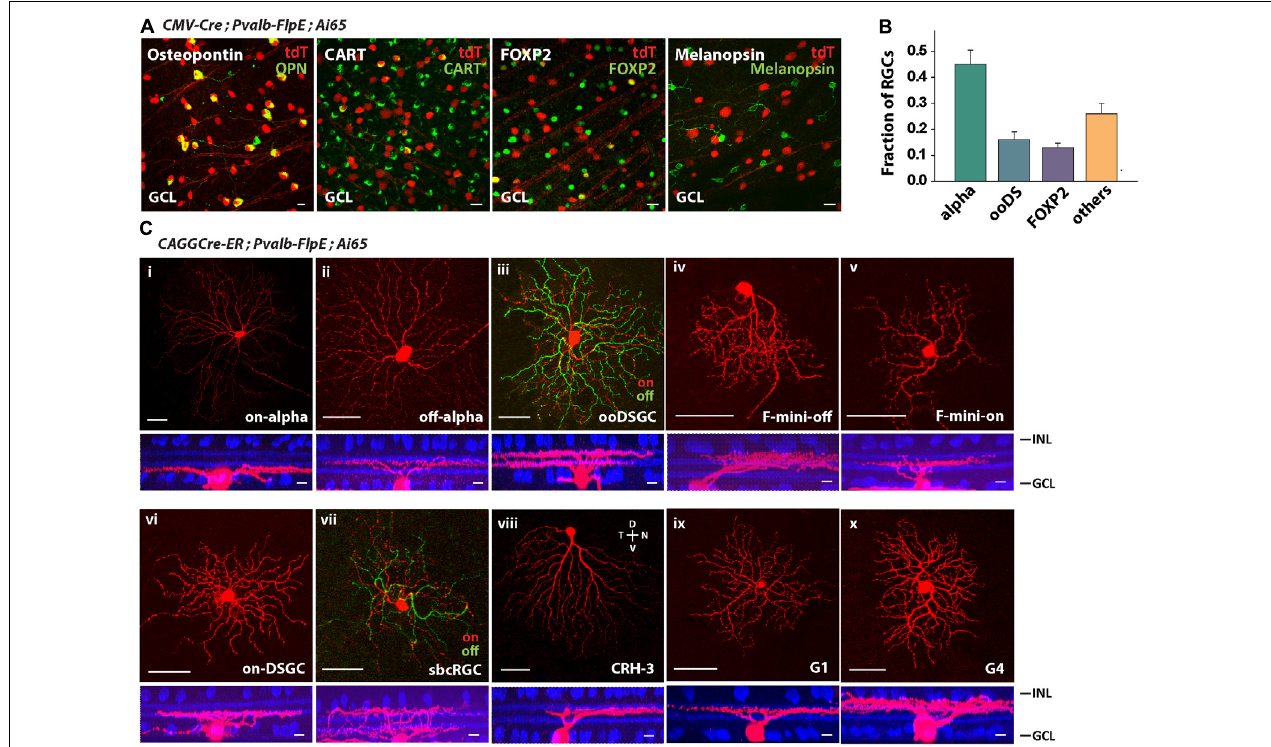
FIGURE 3 | The Pvalb-FlpE driver targeted multiple RGC types. (A) The Pvalb-FlpE driver was crossed with CMV-Cre and Ai65 mice. Immunostainings were performed by using antibody markers for 4 different RGC types: Osteopontin for alpha RGCs, CART for ooDSGCs, FOXP2 for F-RGCs, and melanopsin for ipRGCs. Scale bar, 20 µ m. (B) Proportions of RGC types targeted in the Pvalb-FlpE driver. n = 6 retinas from 6 animals (6 litters). (C) RGC types extracted from CAGGCre-ER;Pvalb-FlpE;Ai65 retinas without tamoxifen administration. Flat-mount view (top) and side view (bottom) with ChAT (blue) labeling. Scale bar: 50 µ m for the flat-mount view, 10 µ m for the side